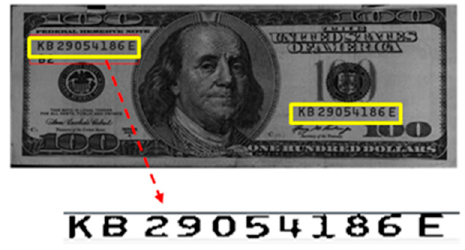
Figure 2. Example of serial number code (USD 100 bill).